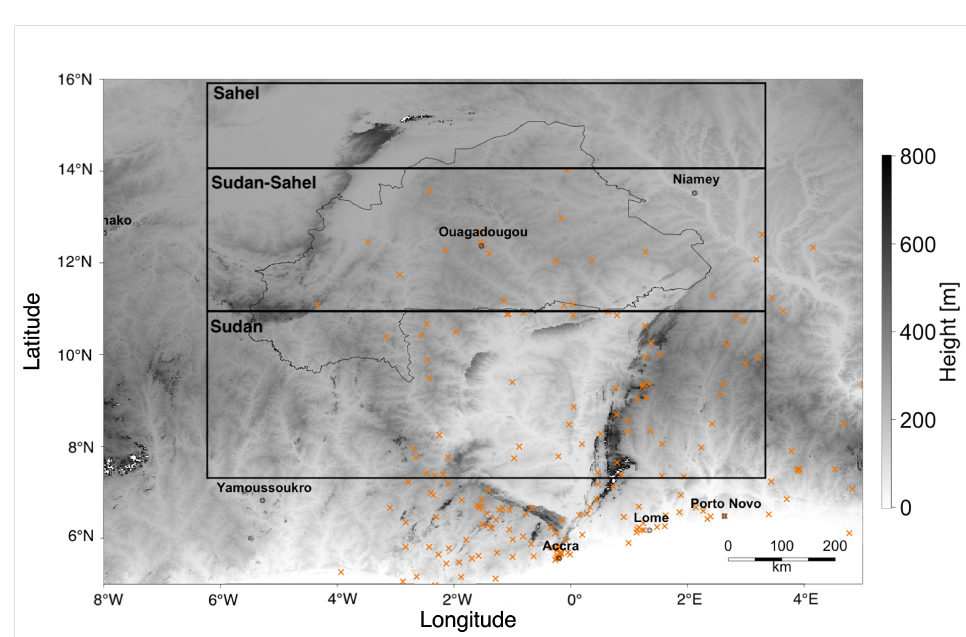
Figure A1. Location of the available TAHMO stations in West Africa.